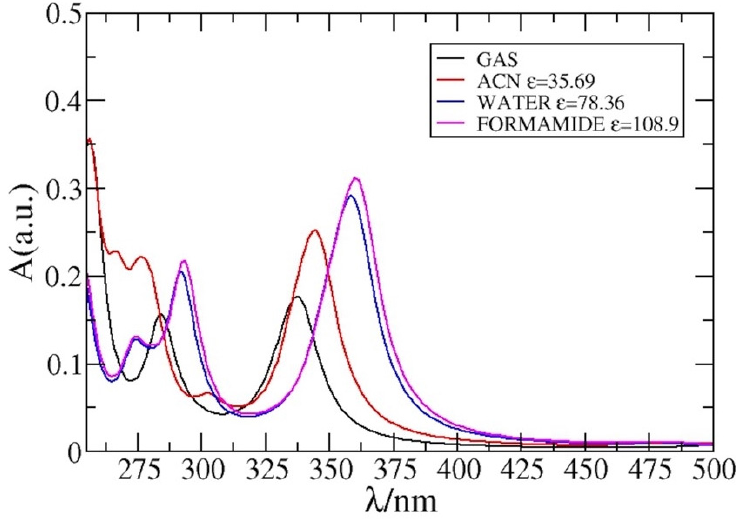
Figure 4. Absorption spectra of [Cu(opba)] 2 − for the isolated species (gas) and in polar solvents (ac- (acetonitrile, water, and formamide). etonitrile, water, and formamide).